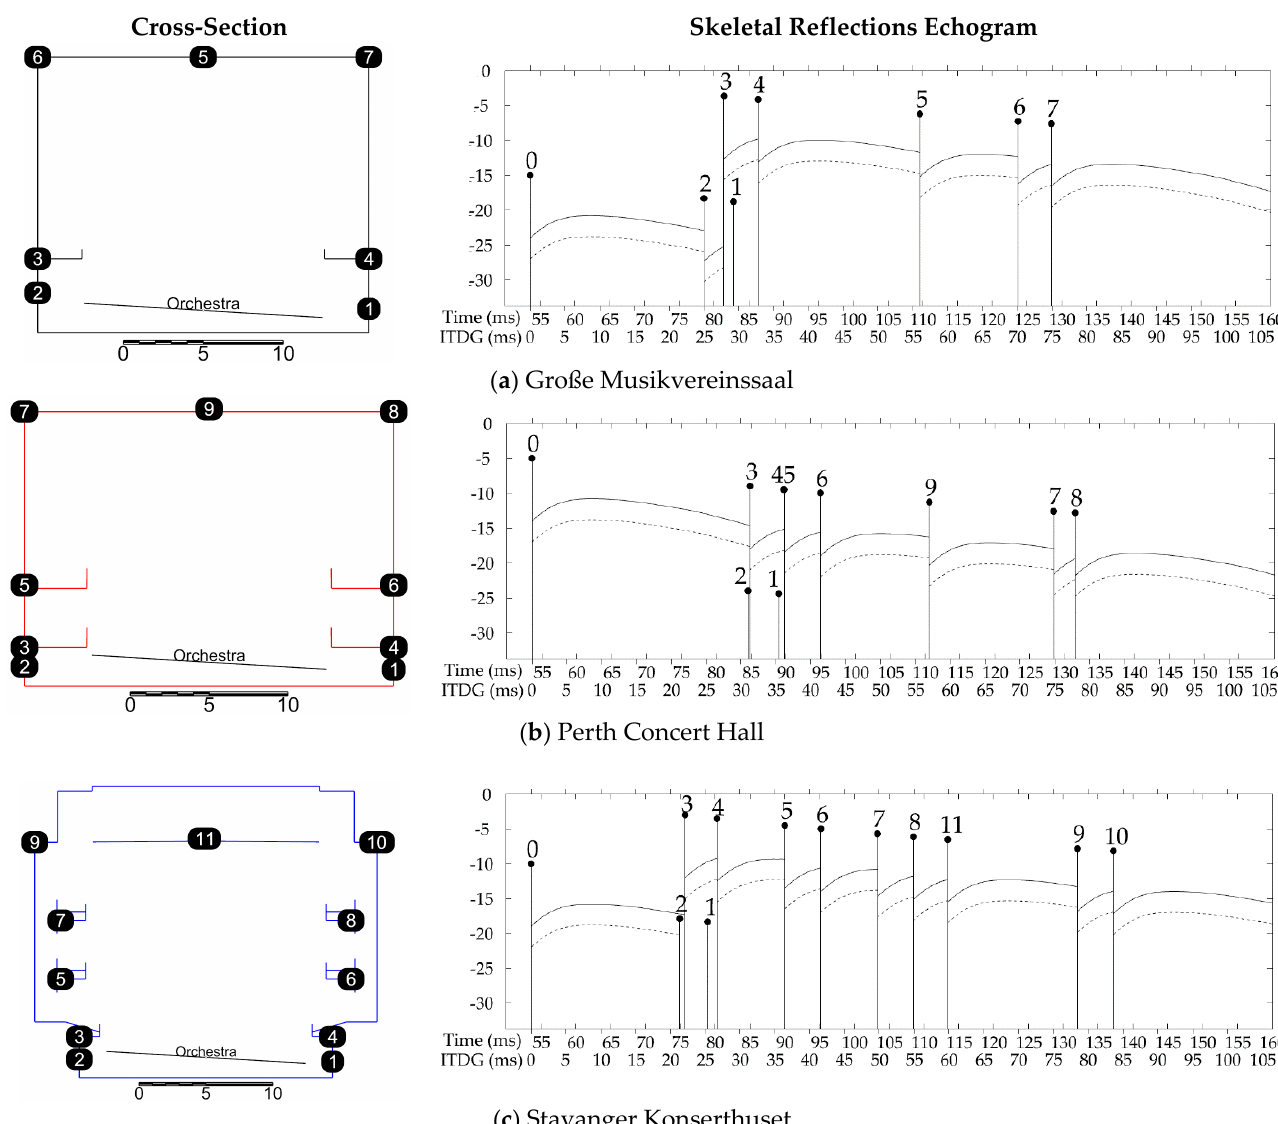
Figure 3. Skeletal Reflections Analysis for three concert halls: ( a ) Große Musikvereinssaal, ( b ) Perth Concert Hall, ( c ) Sta- vanger Konserthuset. Time indicates the absolute time of arrival, and Initial Time Delay Gap (ITDG) is the arrival time after the direct sound. The dashed line indicates the absolute threshold of perceptibility after Schubert. The solid line is the probable threshold for useful contribution.